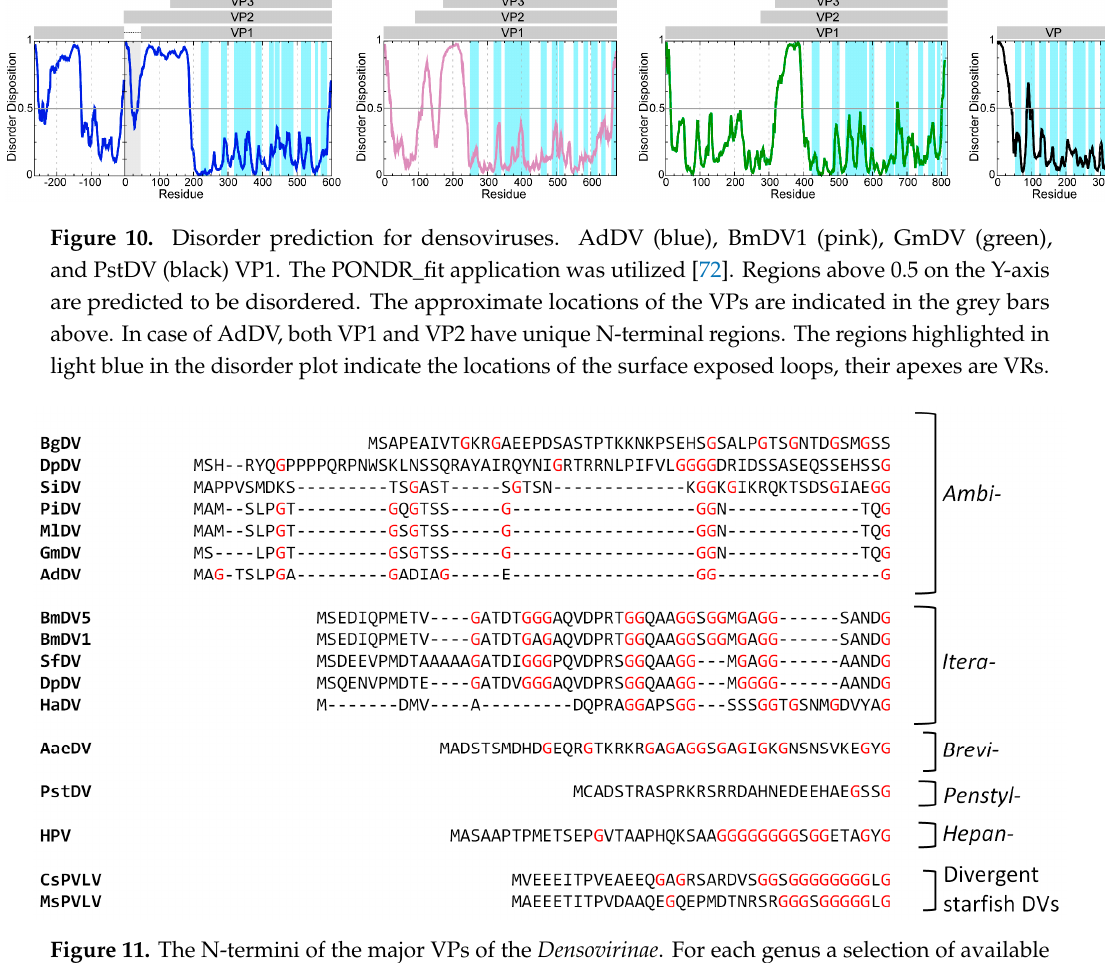
Figure 11. The N ‐ termini of the major VPs of the Densovirinae . For each genus a selection of available VP sequences are shown for the N ‐ terminal 20–50 amino acids. All glycine residues are in